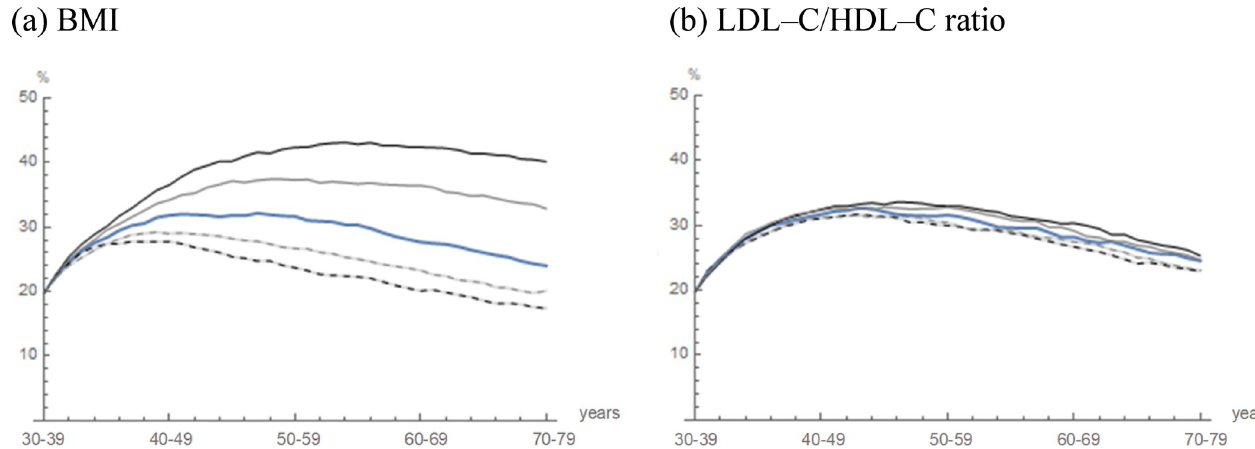
Fig 6. Projected prevalence of fatty liver with variations by changes in the predictive algorithms of BMI and LDL–C/HDL–C ratio. The trajectories of the projected prevalence in cohort 2 (blue curve) are illustrated. The mean prevalence in which the predicted BMI and LDL–C/HDL–C ratio were varied by − 1.0% (a dashed black curve), − 0.5% (a dashed gray curve), 0.5% (a solid gray curve) and 1.0% (a solid black